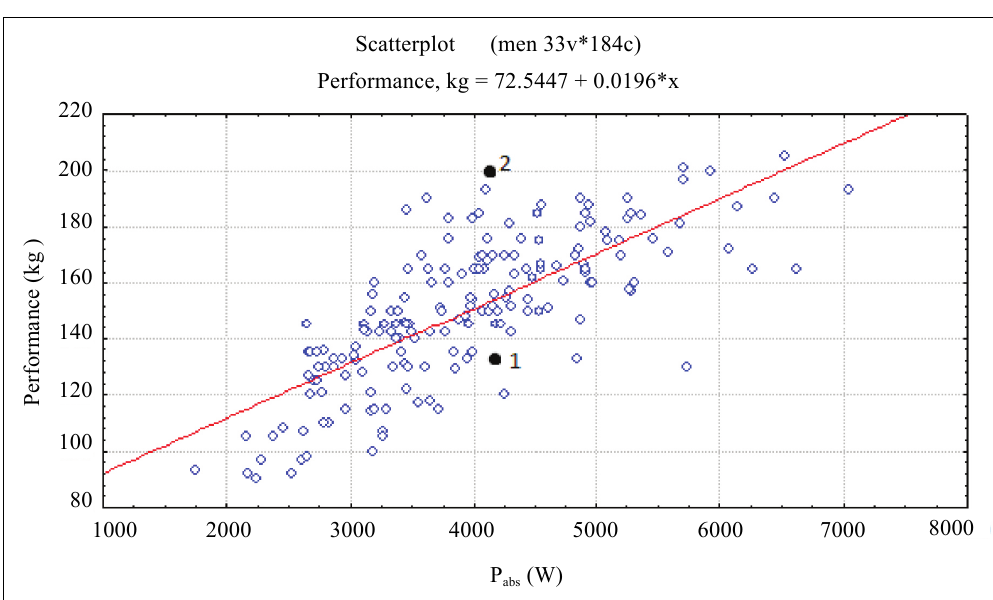
Figure 2. The correlation field ( r = – .75) and the